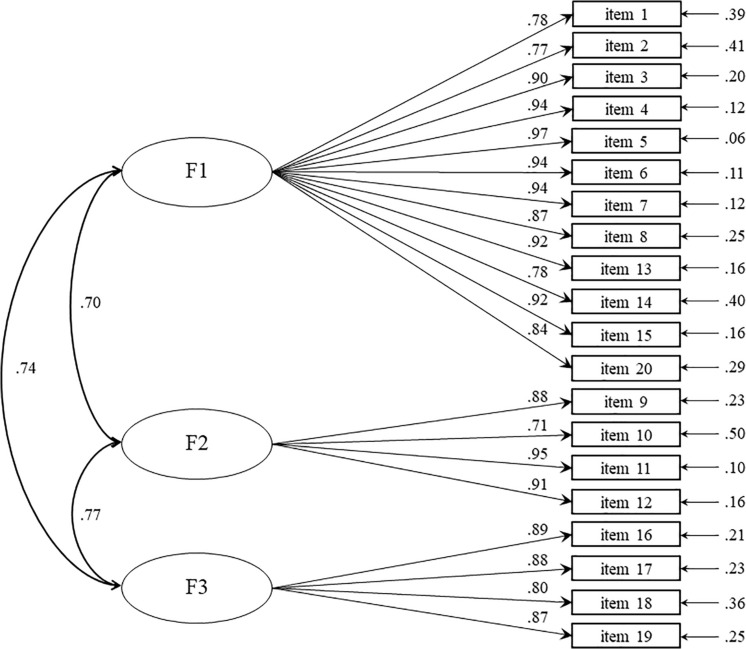
Measurement model with standardized parameters (n = 467).